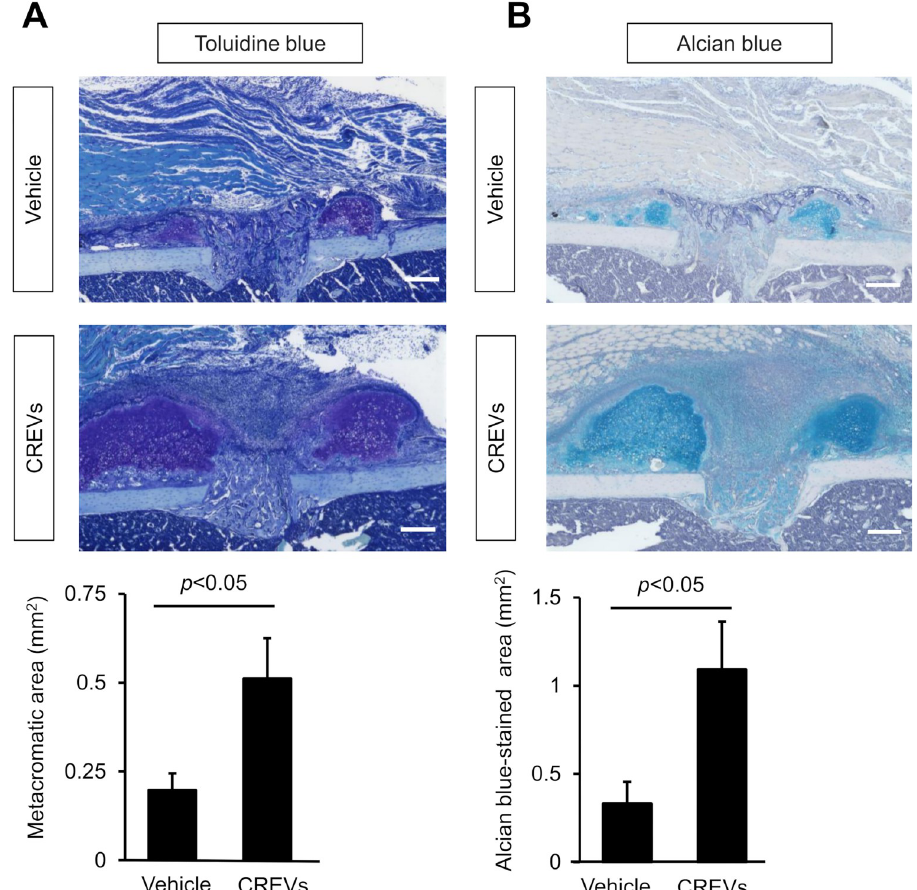
Fig 4. Effects of the local administration of CREVs on the chondrogenic marker at damaged sites. (A) Images of Toluidine blue-stained sections and the area of the metachromatic-stained region at the damaged site 7 days after the femoral bone defect. Results are expressed as the means ± SEM of 8 mice per group. (B) Images of Alcian blue-stained sections and the area of the Alcian blue-stained region at the damaged site 7 days after the femoral bone defect. Results are expressed as the means ± SEM of 6 (Vehicle) or 8 (CREVs) mice per group, respectively. Scale bars indicate 200 μ m. Statistical analyses were performed using the Mann–Whitney U test.